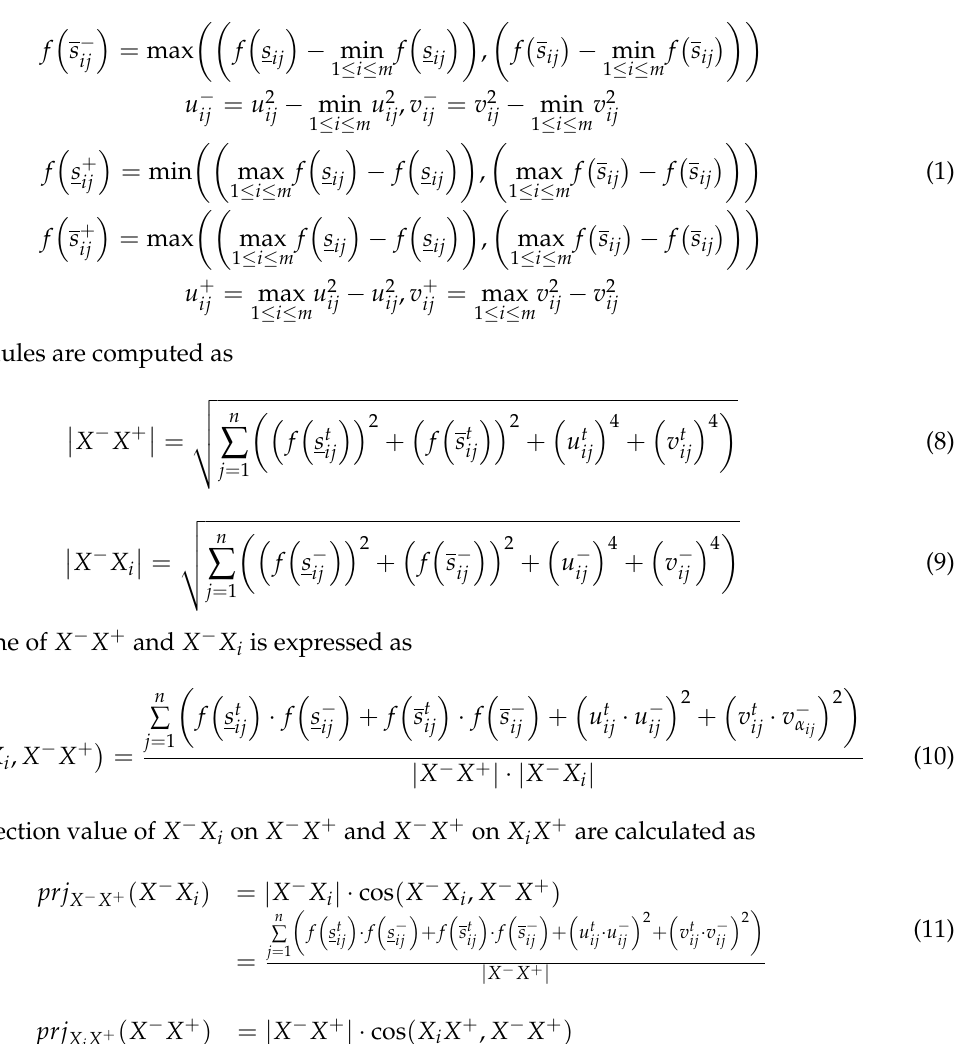
(cid:0) (cid:1)   X − X i and prj X